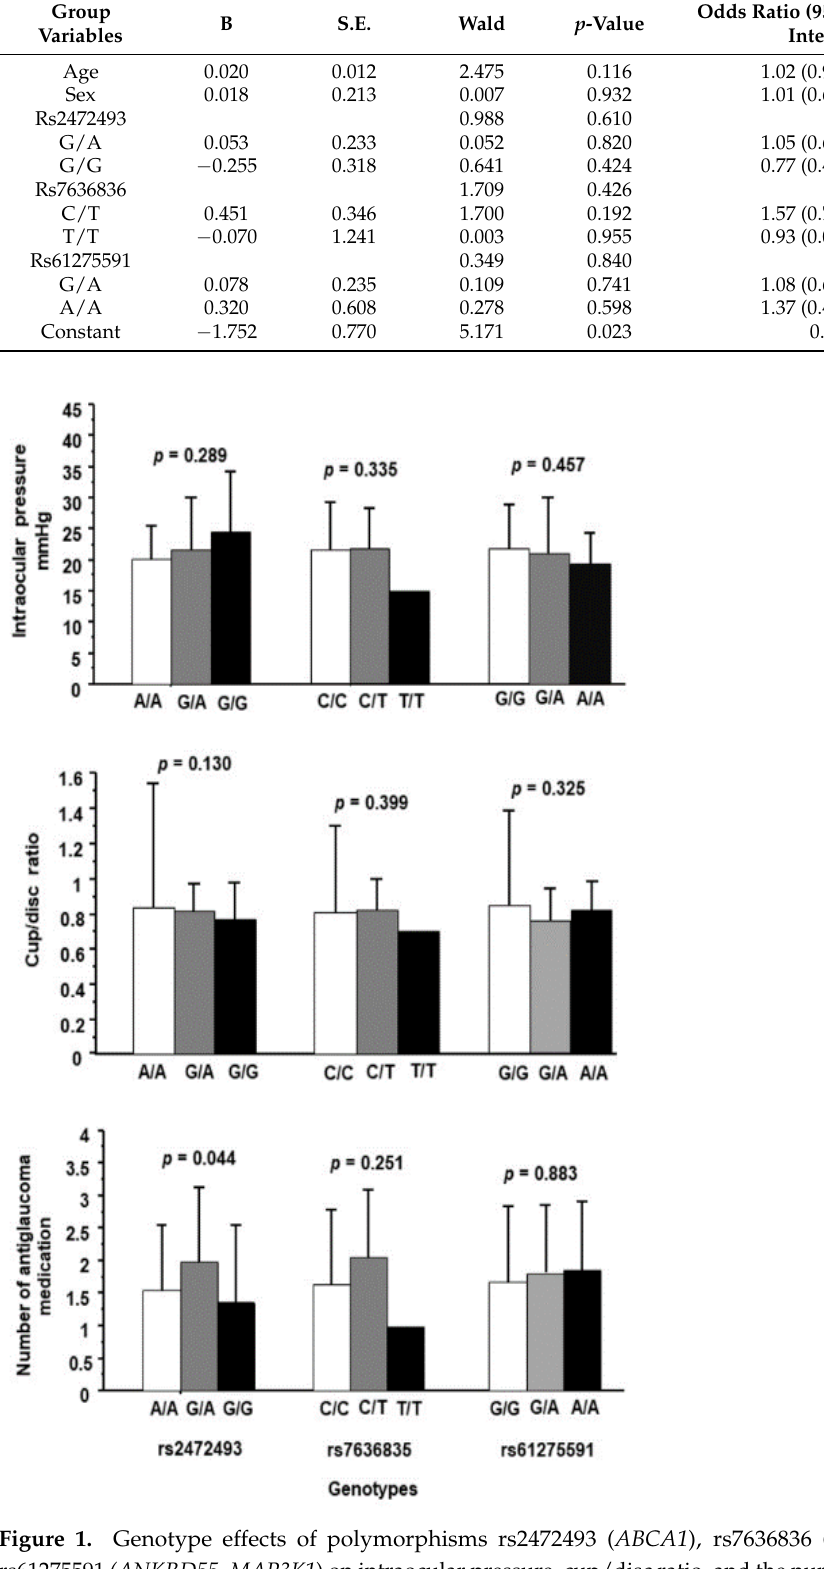
Figure 1. Genotype effects of polymorphisms rs2472493 ( ABCA1 ), rs7636836 ( FNDC3B ), and rs61275591 (ANKRD55 – MAP3K1 ) on intraocular pressure, cup/disc ratio, and the number of an- tiglaucoma medications in primary open-angle glaucoma (POAG)